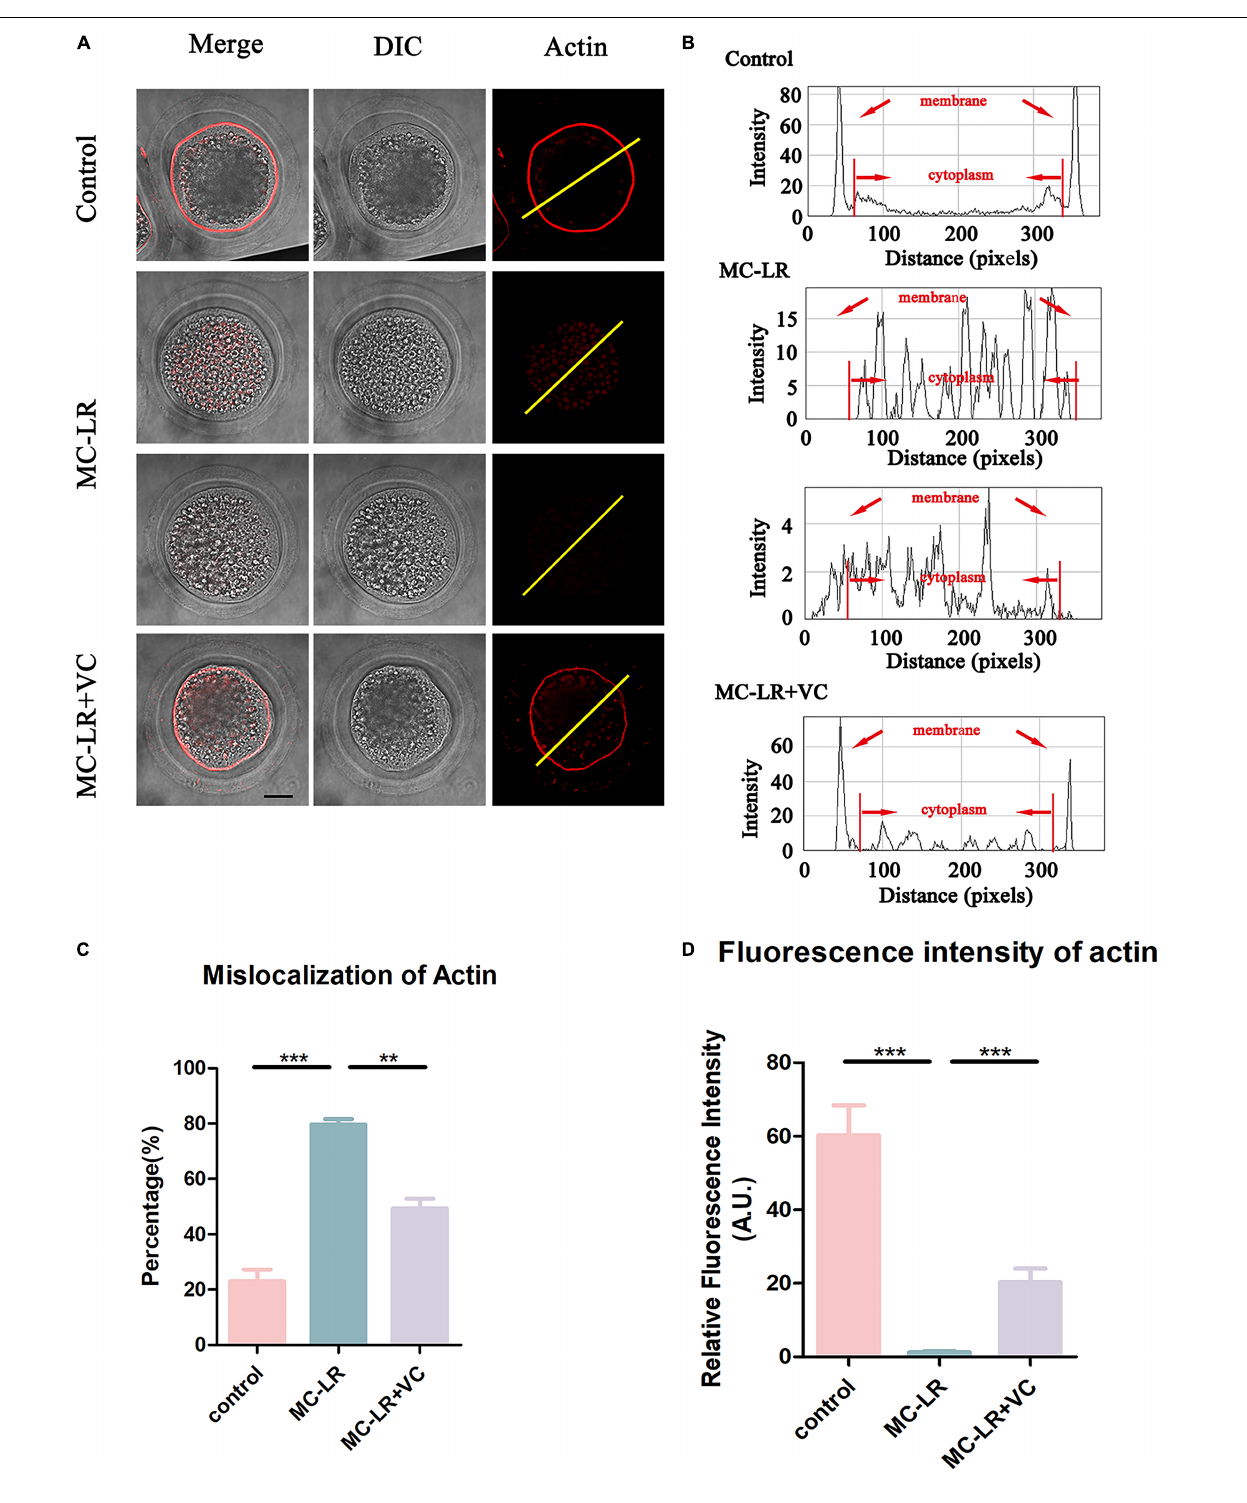
FIGURE 4 | VC protects porcine oocytes from abnormal actin assembly caused by MC-LR exposure. (A) Representative images of F-actin distribution in the control, MC-LR-exposed, and VC-rescued groups. Bar = 20 µ m. (B) Right graphs show fluorescence intensity profiling of phalloidin in oocytes. Lines were drawn through the oocytes, and pixel intensities were quantified along the lines. (C) The rate of mislocalization of actin. (D) Quantitative analysis of the fluorescence intensity of F-actin in the control, MC-LR-exposed, and VC-rescued groups. ** p < 0.01, *** p < 0.001.